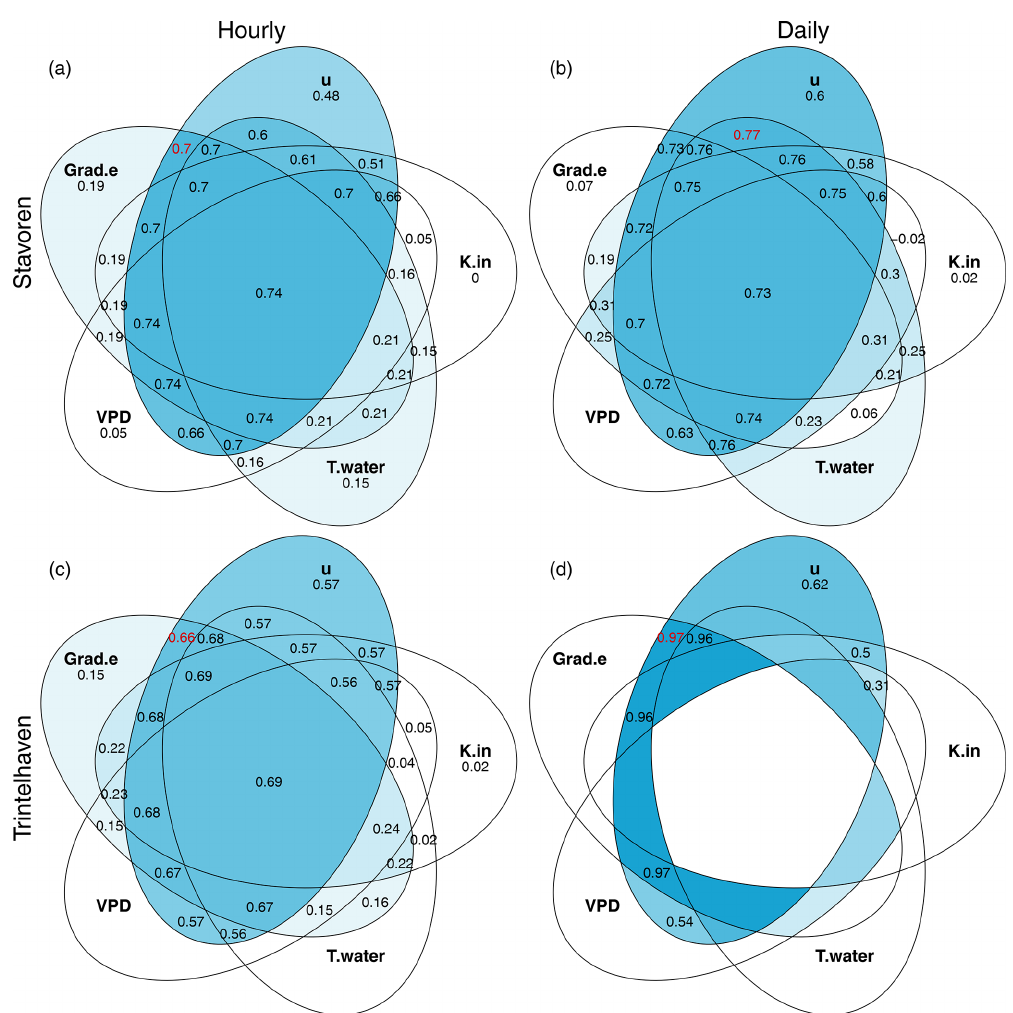
Figure 5. A systematic exploration of which variable or combination of variables (sums) can best explain the dynamics of open water evaporation. The outer “leaves” of the Venn diagram represent the model fit based on the single variables, whereas the summed combinations of variables are represented towards the centre of the diagram. Within each leaf, the adjusted R 2 value is depicted. The higher this value, the bluer the colour of the leaf. The red number indicates the highest R 2 value, indicating the best combination found for a maximum of two variables, i.e. the best “simple” model. The R 2 values were removed if the model fit was found to be insignificant ( p < 0 . 05). The analysis is based on data from the summer of 2019 and is performed at an hourly timescale – Stavoren (a) and Trintelhaven (c) – and a daily timescale – Stavoren (b) and Trintelhaven (d)